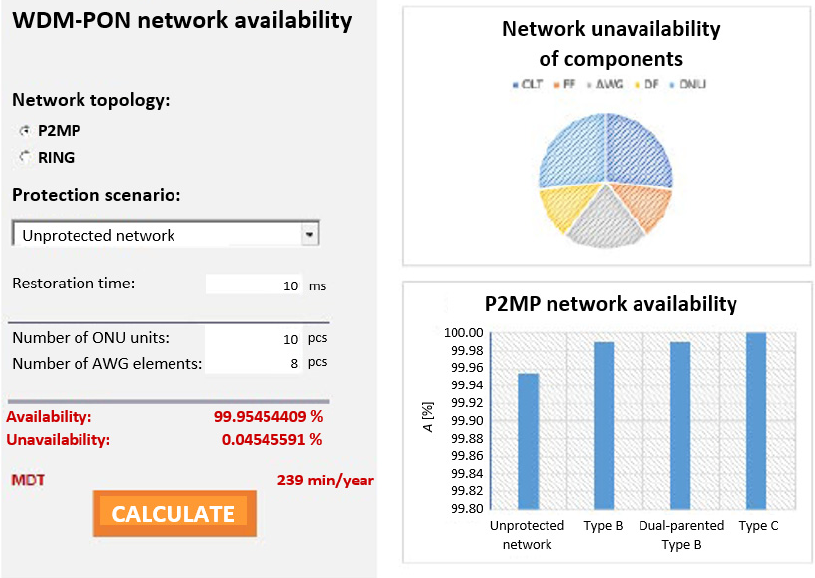
Figure 4. The main screen’s part for the unprotected P2MP WDM-PON network. In the middle of the screen, two graphs related to the selected protection scheme are presented. The upper graph charts the network unavailability of components, and the lower graph presents a comparison of the network availability for all protection scenarios offered for the selected network topology. Immediately after selecting the protection scenario and setting options, resultant values of the network availability and unavailability are shown. On the right side, a WDM-PON network architecture corresponding to the selected P2MP protection scenario is then pictured. For better understanding, an explanation